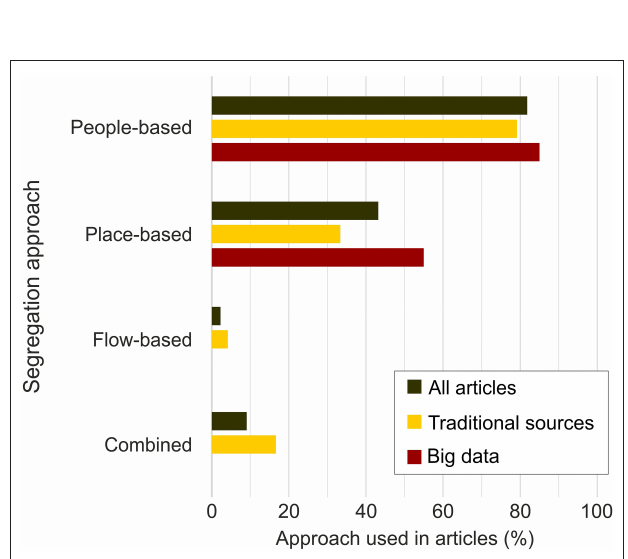
FIGURE 11 | Distribution of approaches used to study activity space segregation in all studies ( n = 44), and separately in studies using traditional data sources ( n = 24) and big data sources ( n =